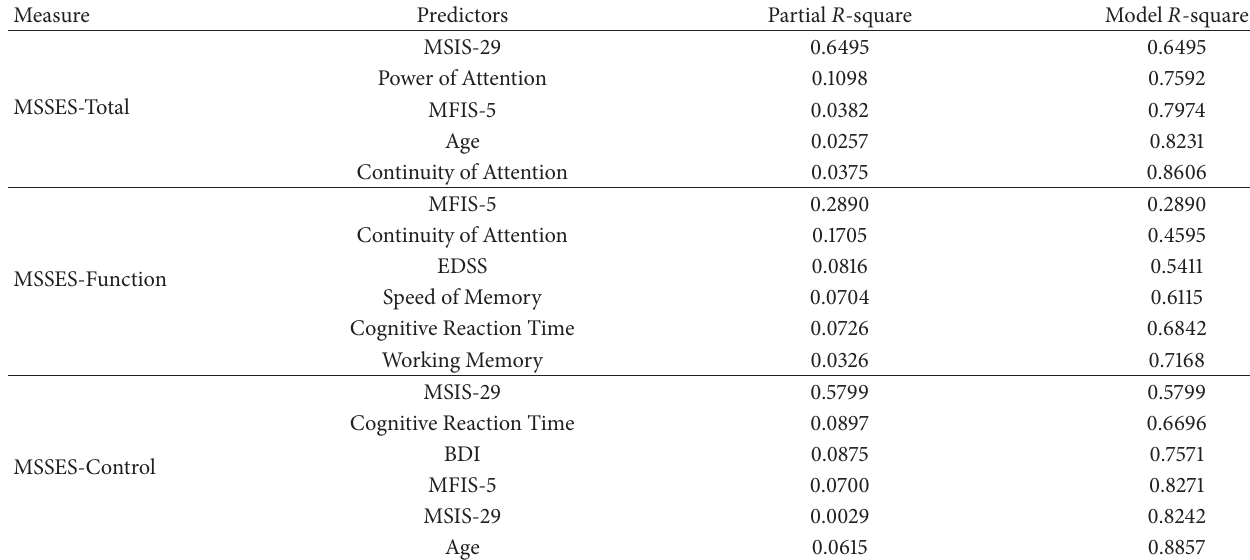
Table 4: Multivariate prediction of self-efficacy scores in persons with CIS and eRRMS ( 𝑁 = 33 ).